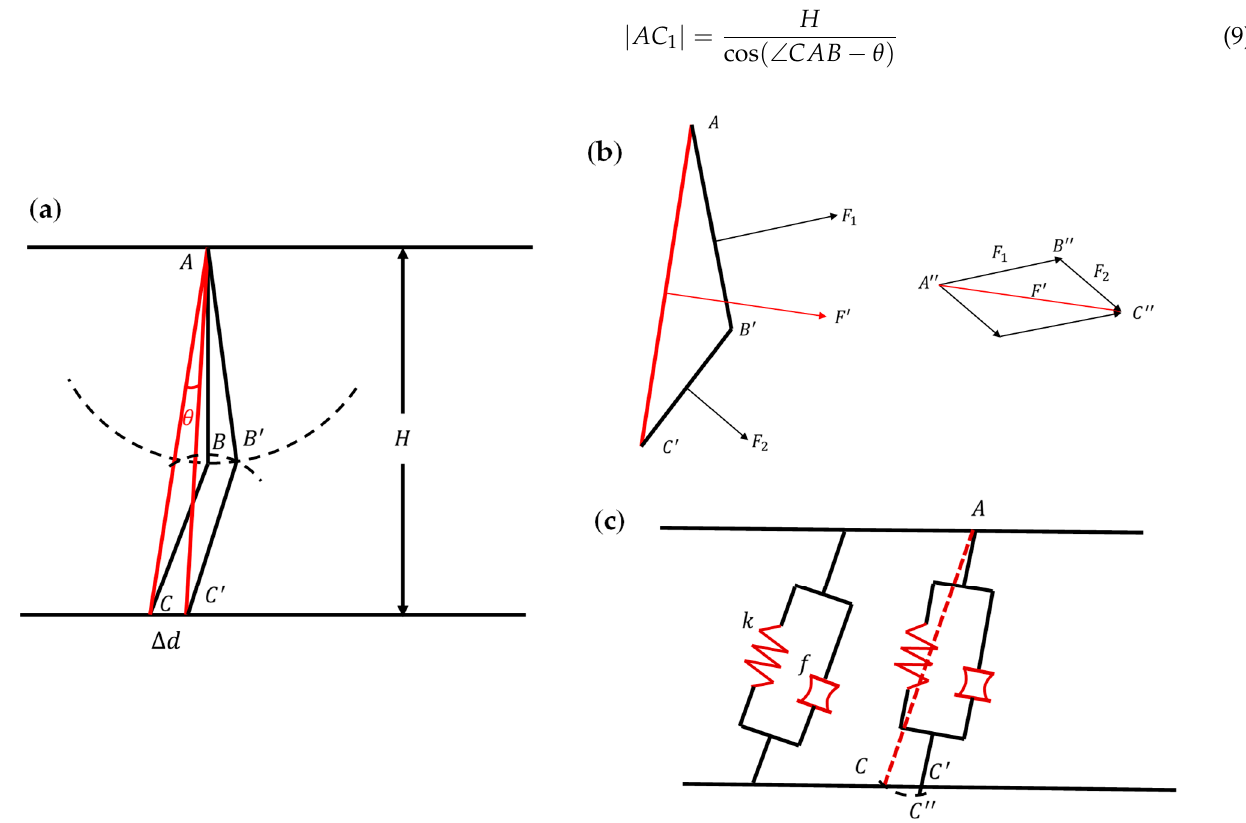
Figure 9. Actuator ‘joint’ mathematical model. ( a ) Deformation of a ‘joint’ in one movement. ( b ) Air pressure work equivalent model. ( c ) Mechanical equivalent model of the structure A − B − C